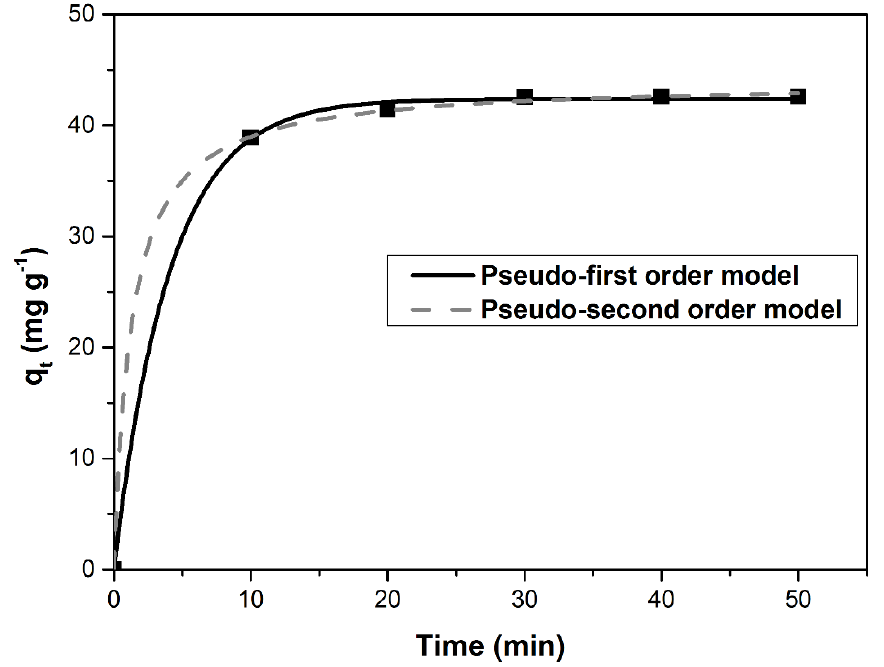
Figure 7. The pseudo-first-order and pseudo-second-order models models tested for MB adsorption on DBPH powder.